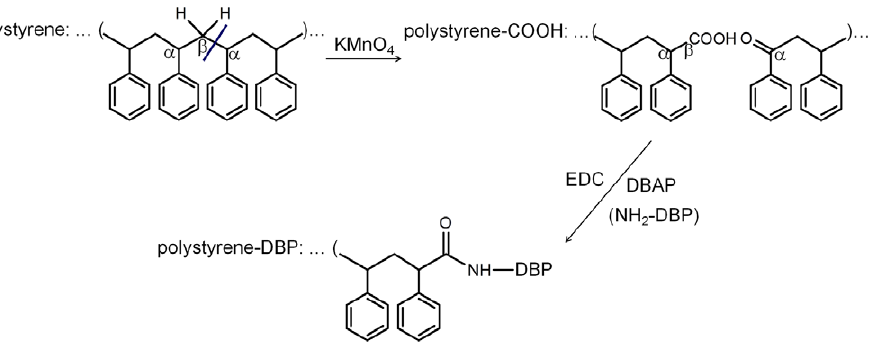
Figure 2. Scheme of one possible reaction in permanganate oxidation of polystyrene and its subsequent reaction with DBAP.